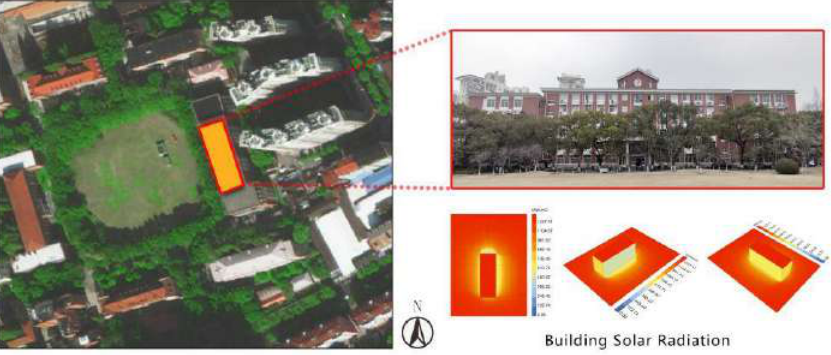
Figure 2. Actual state of the 4th Academic Building and solar radiation analysis of the building.